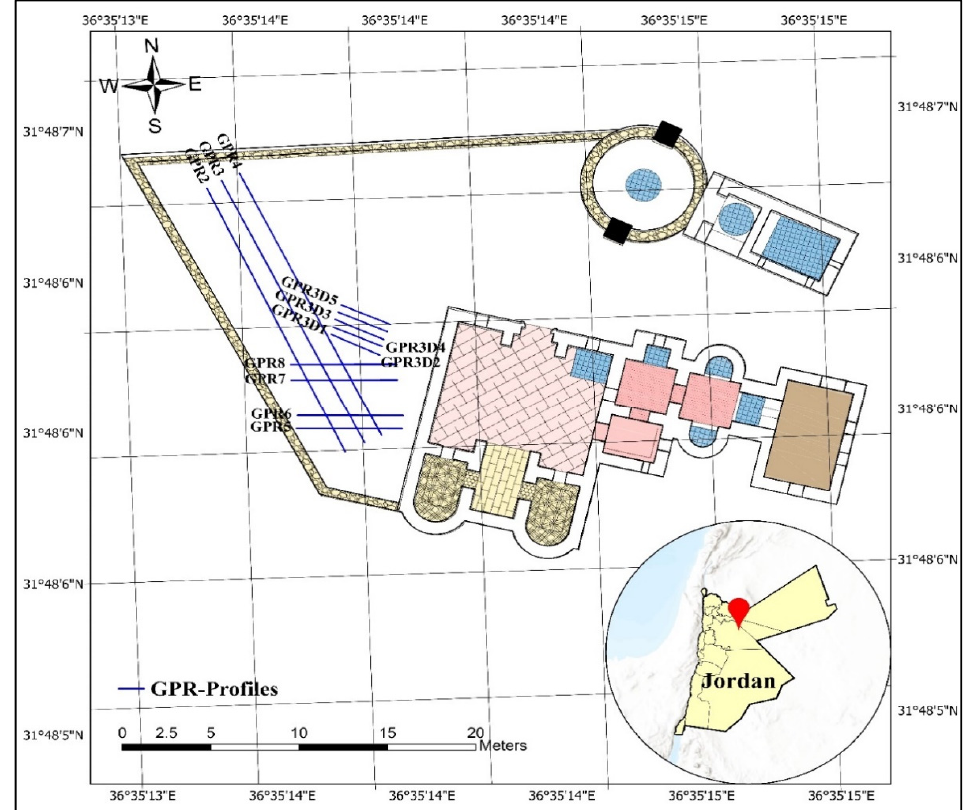
Figure 15. The location map of the GPR profiles at Qaser Amra.